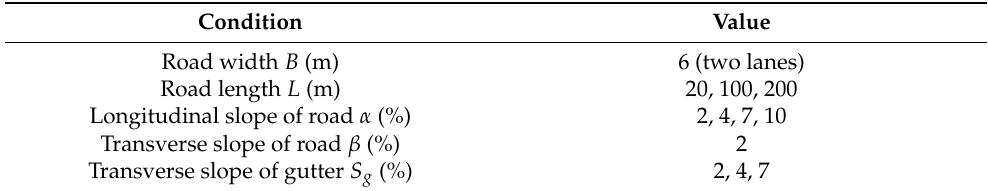
Table 1. Experimental conditions for roads. Table 2. Experimental conditions for drainage